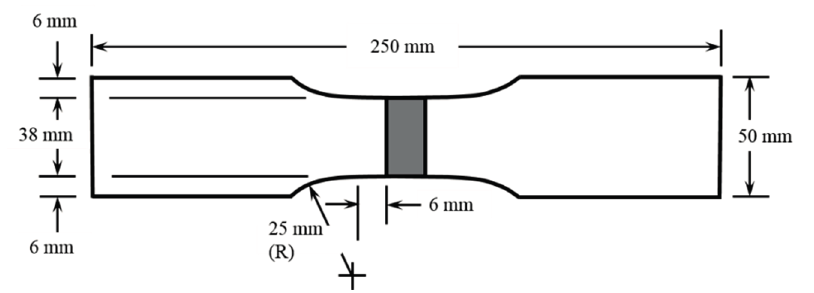
Figure 11. Tensile test specimen